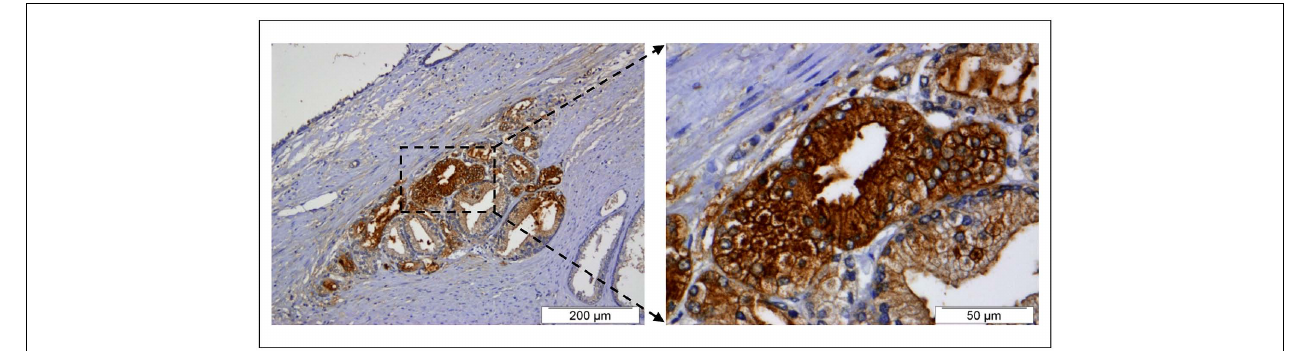
FIGURE 2 | Immunostaining pictures of a prostate cancer tissue using recombinant FTL produced in P. pastoris as tumor diagnostic marker. PprFTL was able to specifically recognize carcinoma cells in middle of a